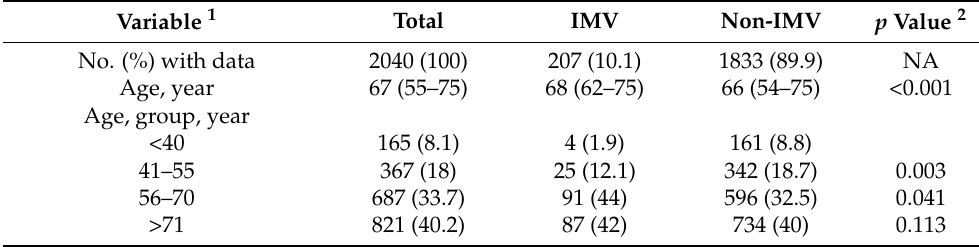
Figure 1. Flow chart of participants enrolled in the study. Abbreviations: SARS-CoV-2: severe acute respiratory syndrome coronavirus 2. Table 1. Baseline patient characteristics based on invasive mechanical ventilation